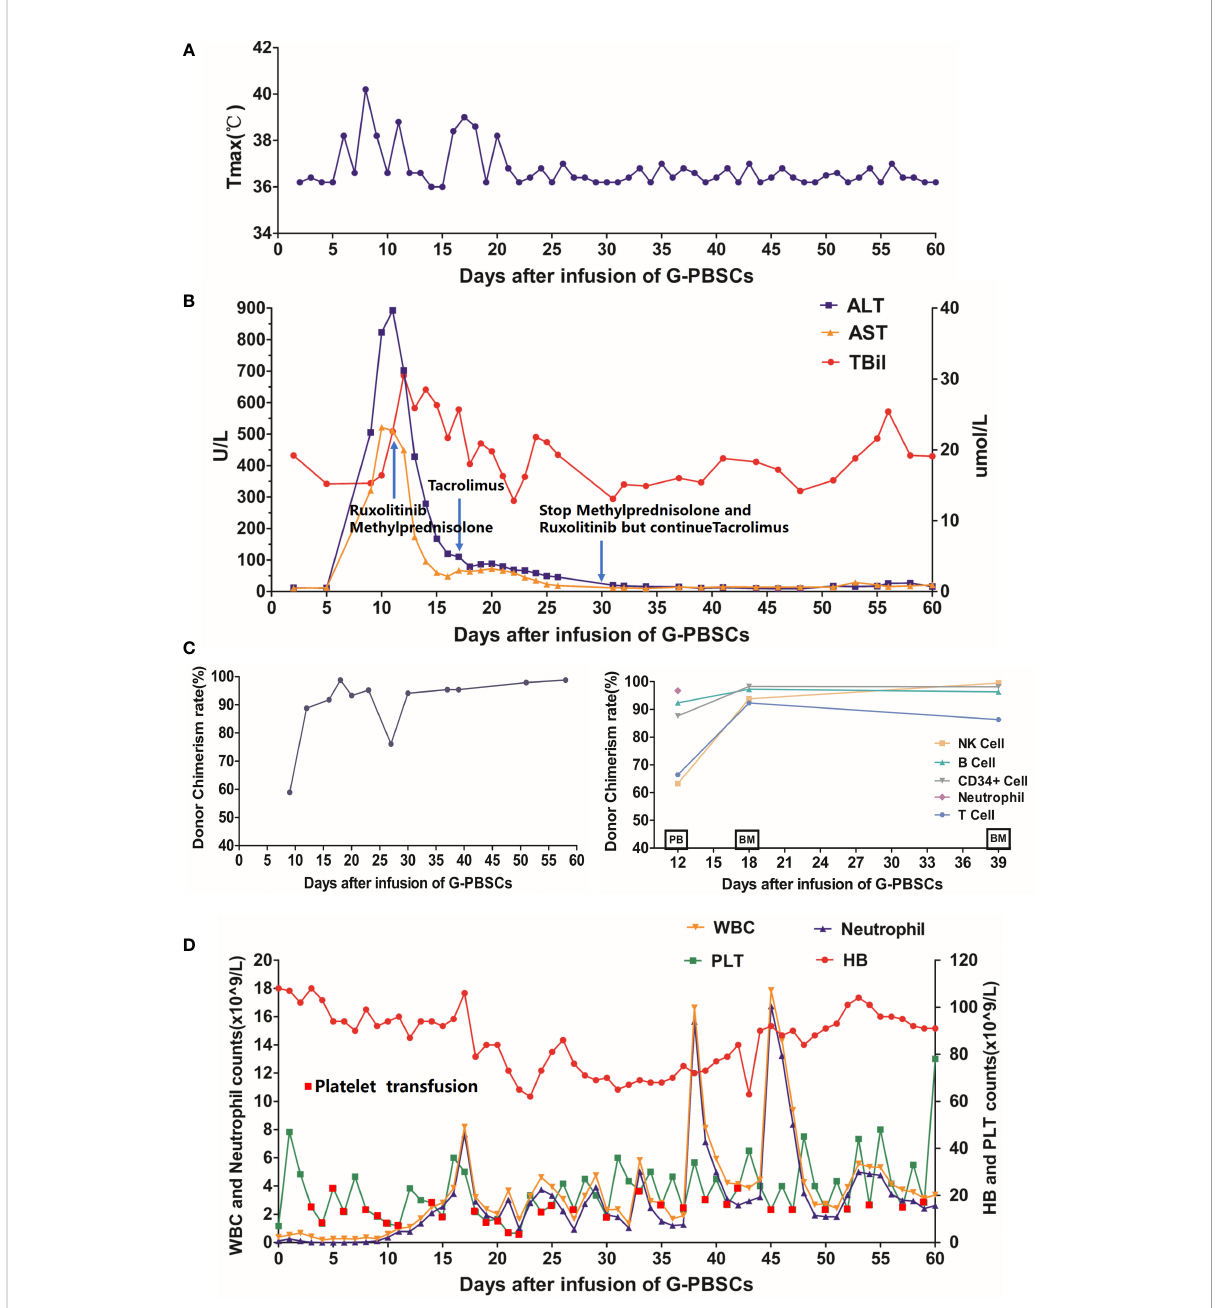
FIGURE 3 (A) Changes in body temperature after the infusion; (B) Changes in alanine aminotransferase, aspartate aminotransferase, and total bilirubin after the infusion; (C) Changes in hematopoietic donor chimerism of the total PB cells (Left Panel) and sorted PB or BM cells (Right Panel) by polymerase chain reaction-based-short tandem repeats assay with a sensitivity of 1%; (D) Changes in PB cell count after the infusion. G-PBSCs, granulocyte colony-stimulating factor-mobilized peripheral blood stem cells; ALT, alanine aminotransferase; AST, aspartate aminotransferase; TBil, total bilirubin; PB, peripheral blood; BM, bone marrow; WBC, white blood cell; HB, hemoglobin; PLT, platelet. PB and BM on the abscissa in (C) indicate the source of specimens for this